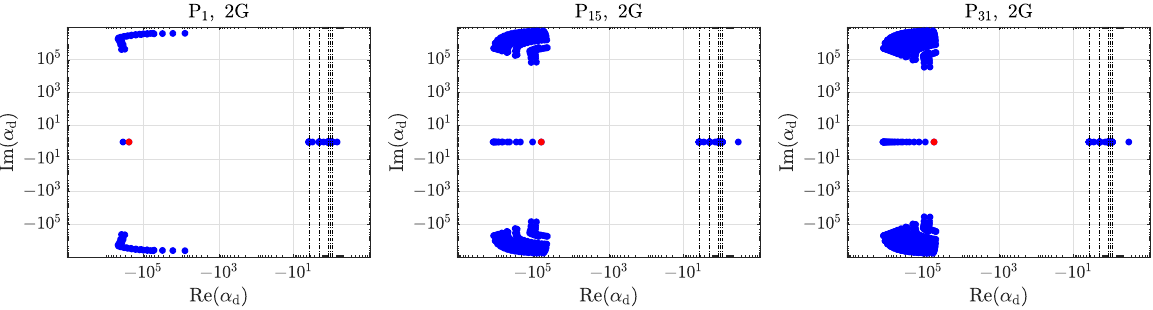
Figure 7: α eigenvalue distribution for a homogeneous system including delayed neutrons. The dotted lines are the values of − λ i